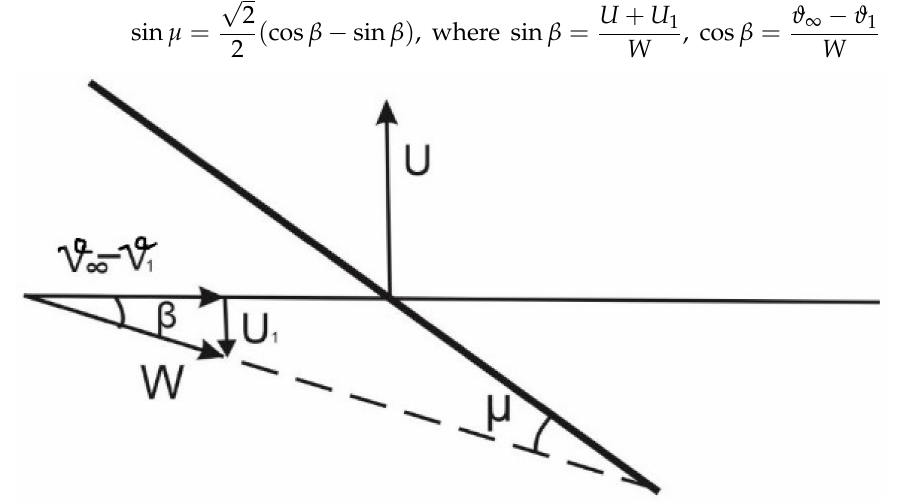
Figure 9. Determination of the relative velocity of the flow incident on the